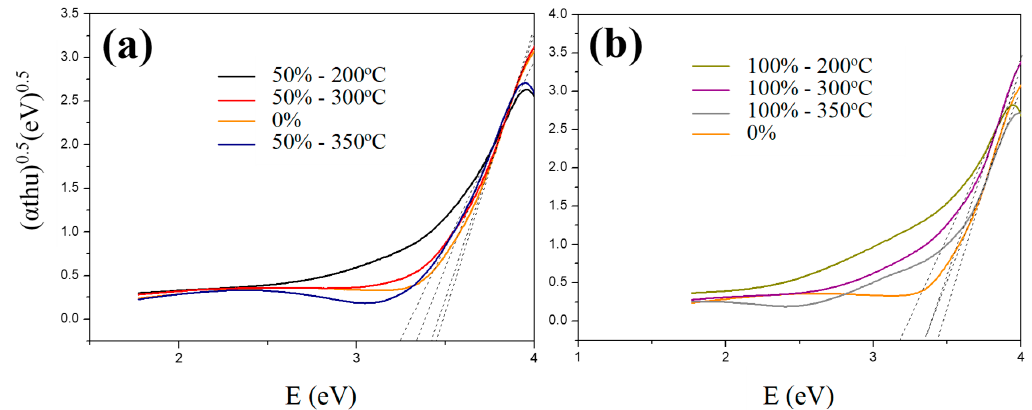
Figure 9. UV-visible transform spectra (Tauc plots) of various C–TiO 2 films synthesized in the glucose solutions with concentrations of ( a ) 50% and ( b ) 100% after calcined at 200, 300, and 350 °C, respectively.